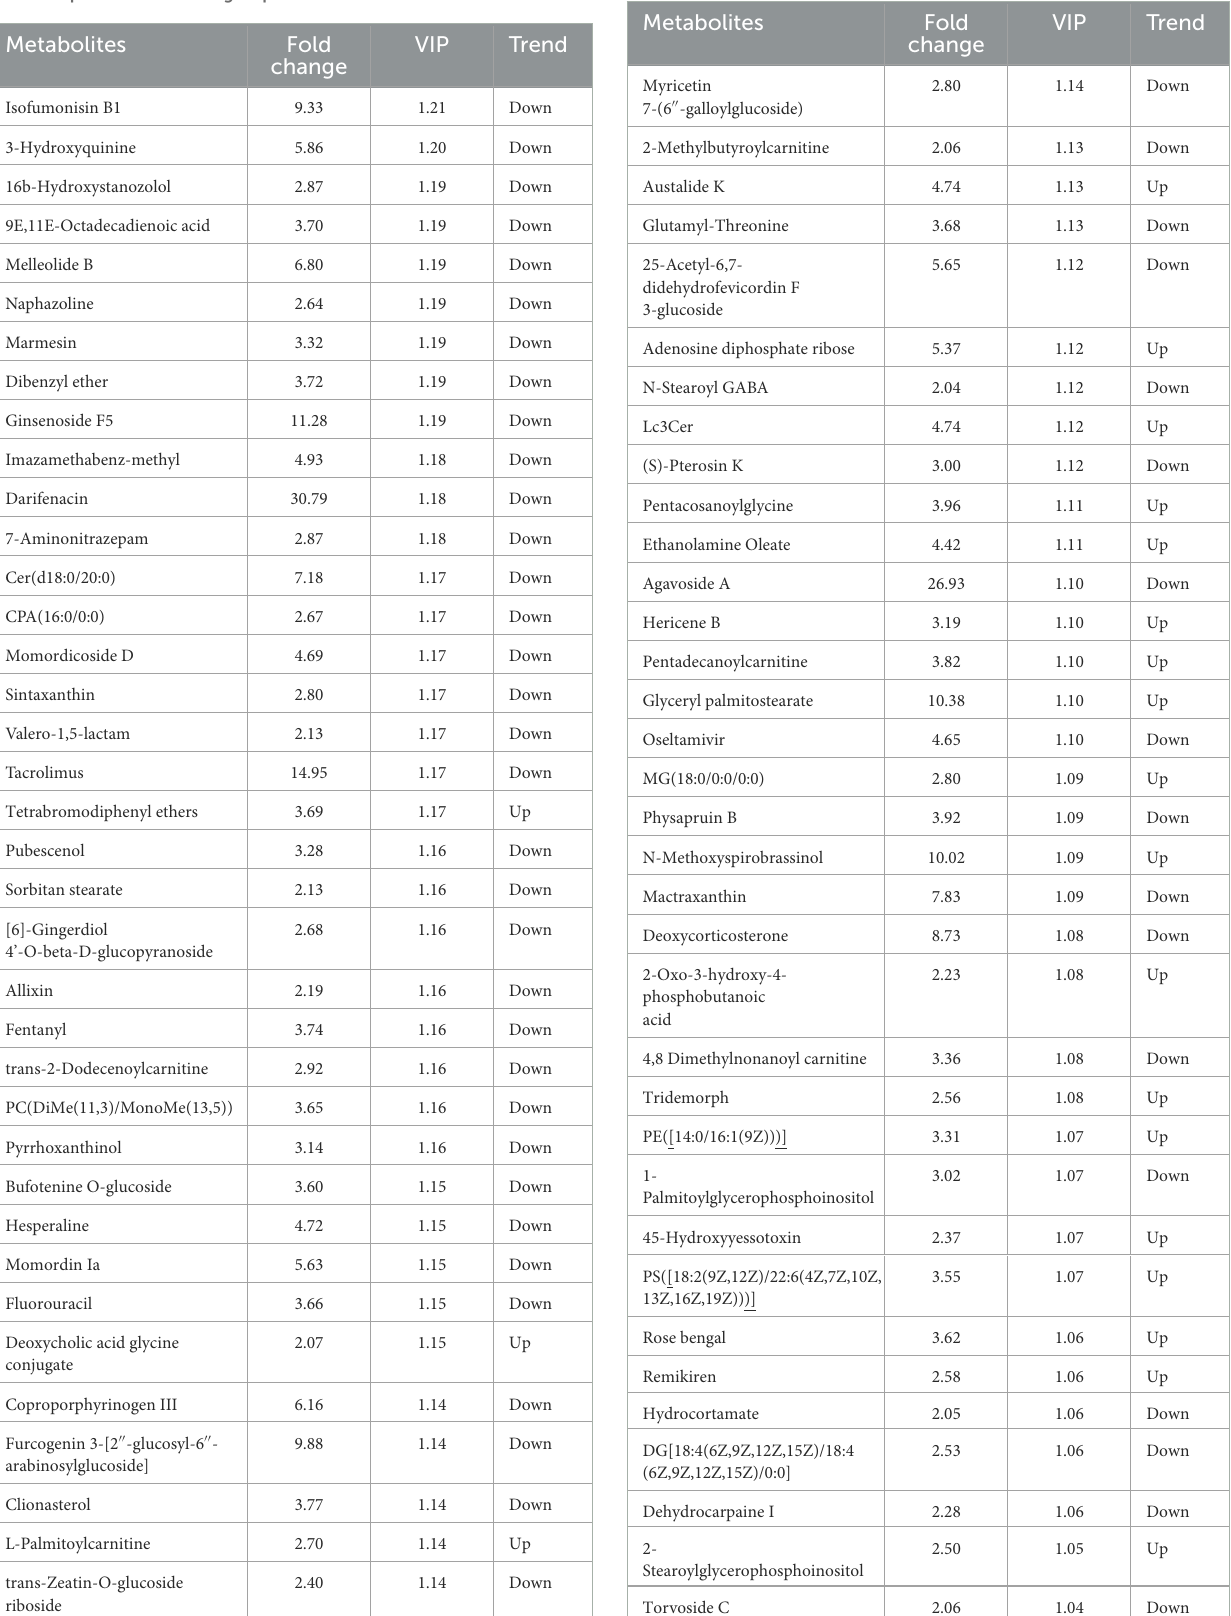
Metabolites Fold VIP Trend change